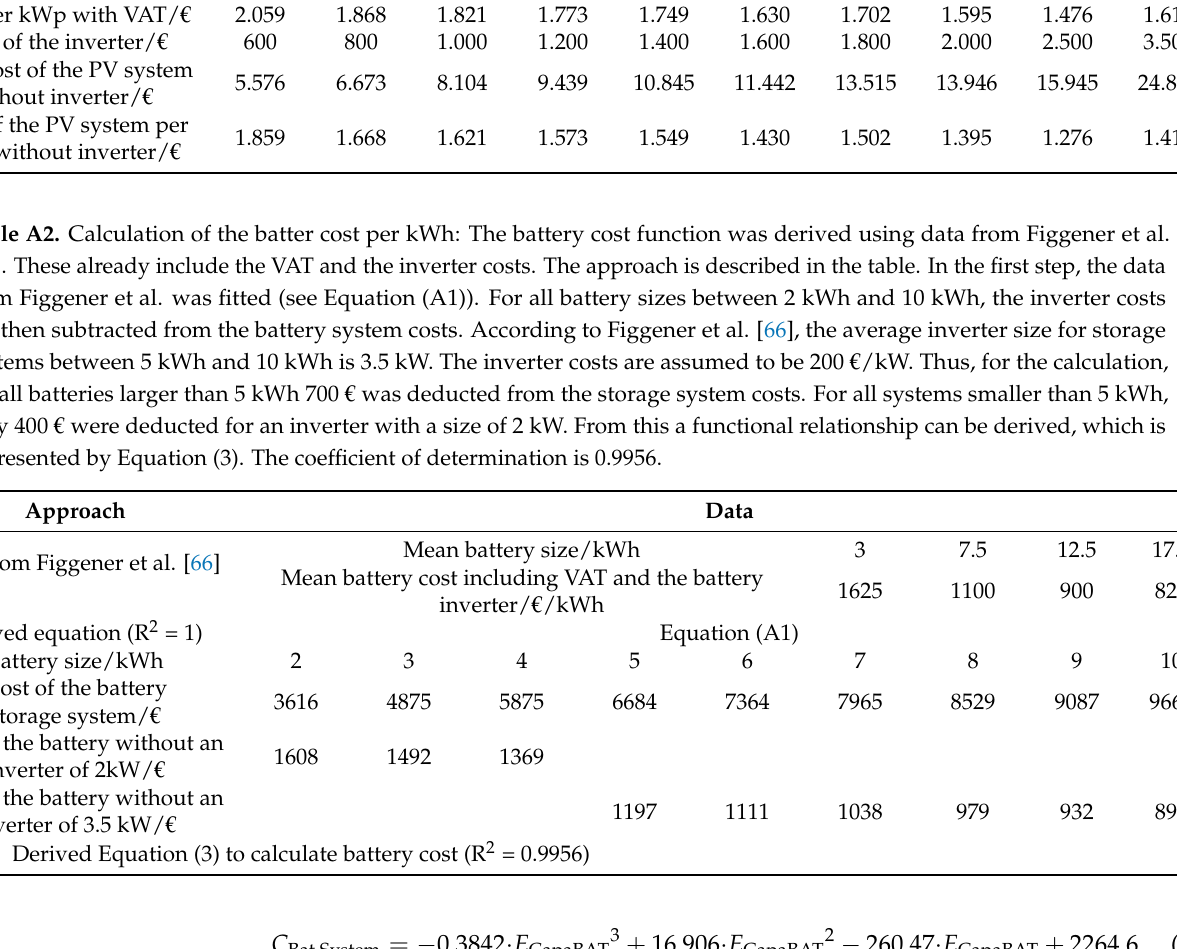
Derived Equation (3) to calculate battery cost (R 2 = 0.9956)